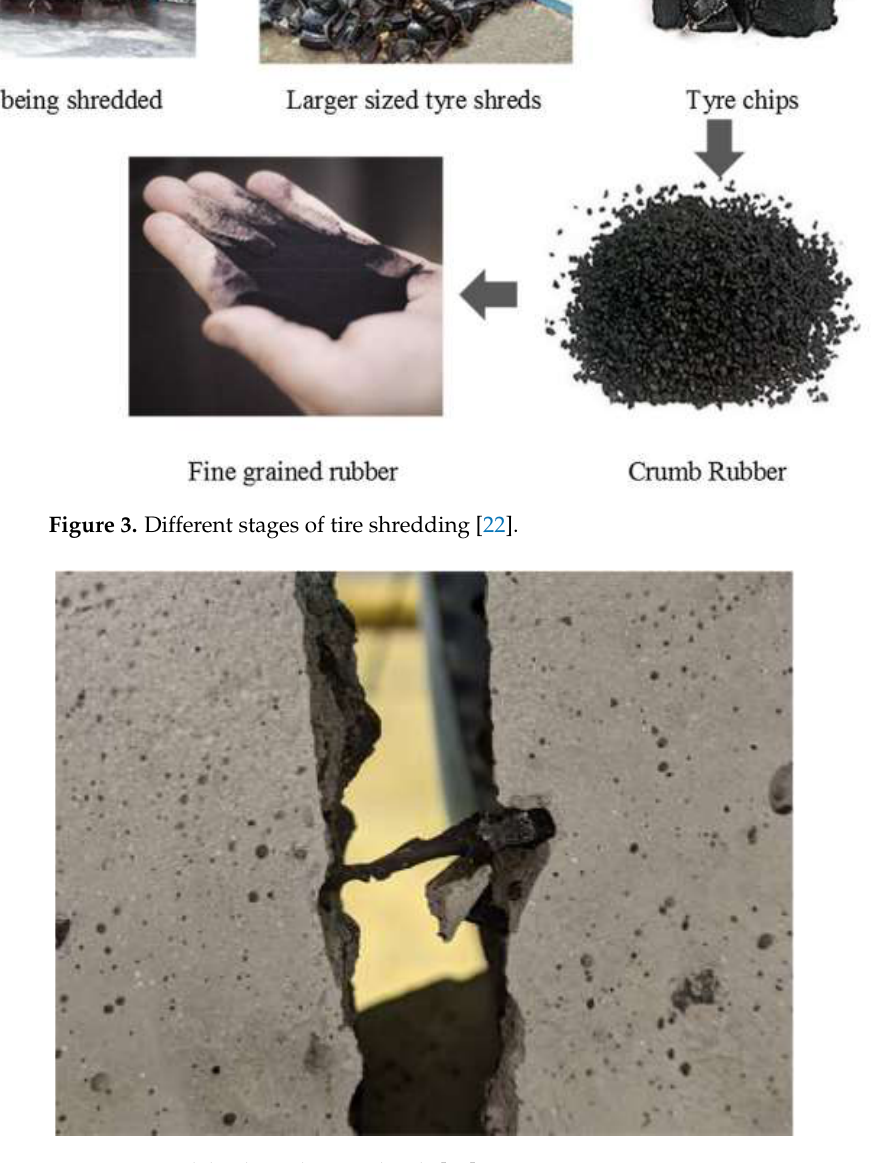
Figure 4. Crack bridging by tire shreds [23].